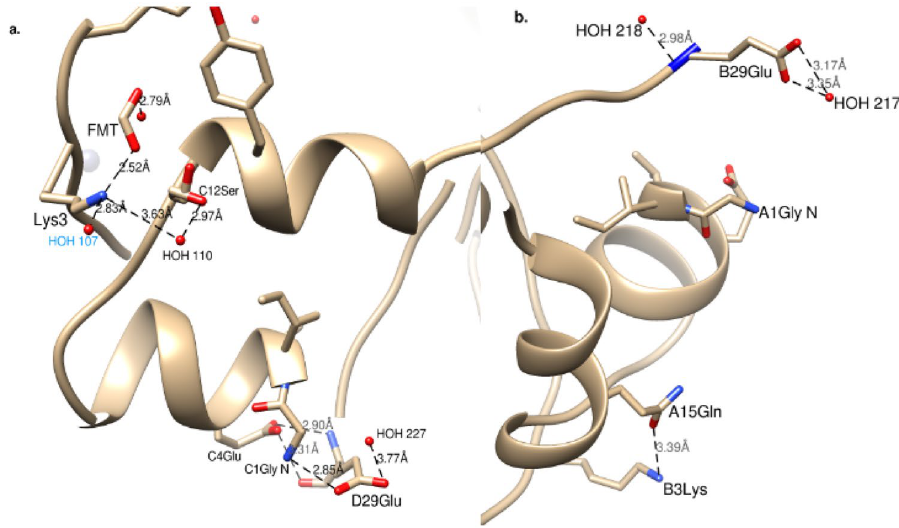
Figure 2. Hydrogen net bonds of the IGlu two mutations 3Lys and 29Glu for D-chain ( a ) and B-chain ( b ). Symmetry water 107 is labelled blue. Figure created using Chimera v1.8.1 http://www.cgl.ucsf.edu/chime ra/.